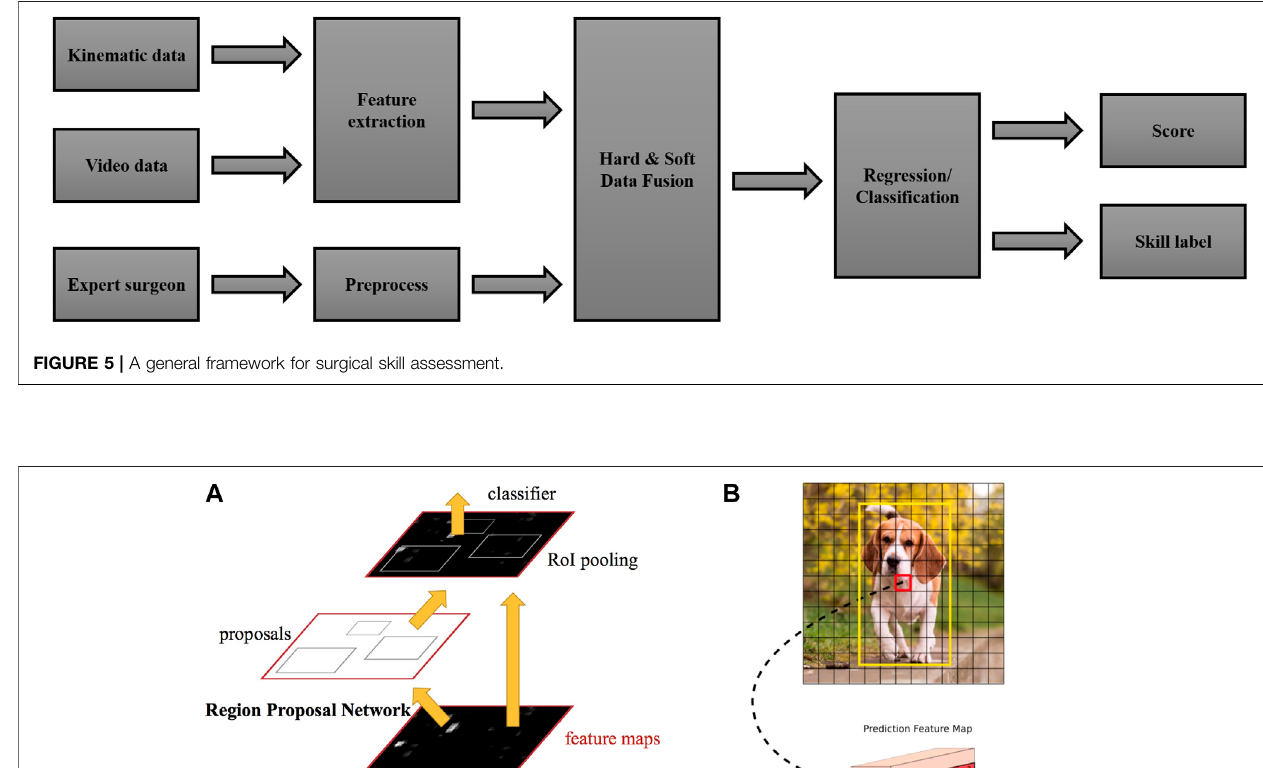
Frontiers in Robotics and AI |